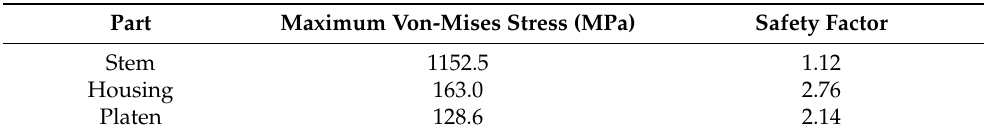
Figure 8. Von-mises stress of platen. Table 2. Results of the structural strength analysis.